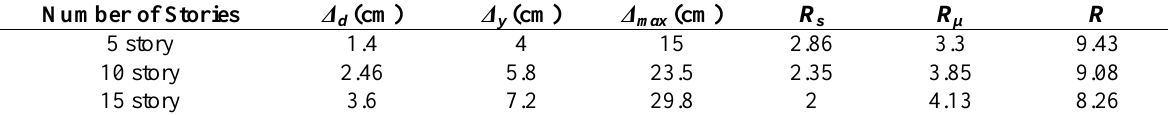
Table 3. Response modification factors from pushover analysis of the structures